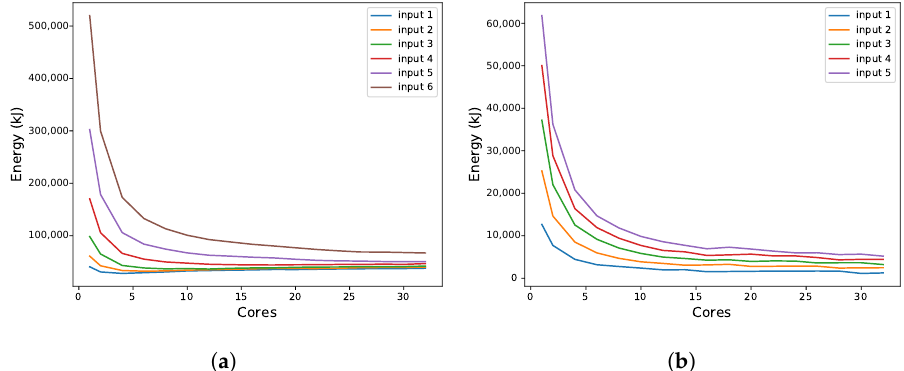
Figure 7. Energy consumption identified in the execution of applications while varying the number of cores for several input sizes. ( a ) Raytrace energy consumption. ( b ) OpenMC energy consumption.